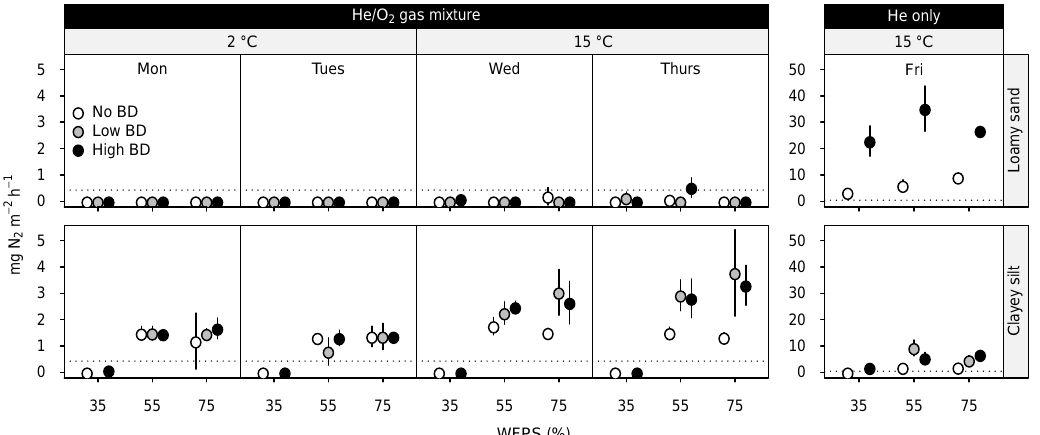
Figure 4. Mean N 2 fluxes (mgm − 2 h − 1 ) from loamy sand and clayey silt incubated under different water-filled pore spaces (WFPSs, %) with different amounts of digestate (0mL per sample ring: no BD, 17.6mL: low BD and 35.2mL: high BD). The first to the fourth days of the incubation were measured in an aerobic He–O 2 headspace (with 2 days at 2 ◦ C followed by another 2 days at 15 ◦ C) while on the fifth day measurements were conducted in an anaerobic headspace with pure He (at 15 ◦ C). Error bars show standard deviations; if bars are not visible, they are smaller than the symbols of the means. The dotted horizontal lines depict the average blank value; single flux rates lower than the respective lank value were set zero. Under an aerobic atmosphere, N 2 fluxes from loamy sand were zero or rather negligible, while fluxes from clayey silt show a distinct increase with WFPS and higher fluxes at 15 ◦ C. Under an anaerobic atmosphere, mean fluxes from loamy sand increased by orders of magnitude, while the fluxes from clayey silt increased as well, but more gently compared to the sand.